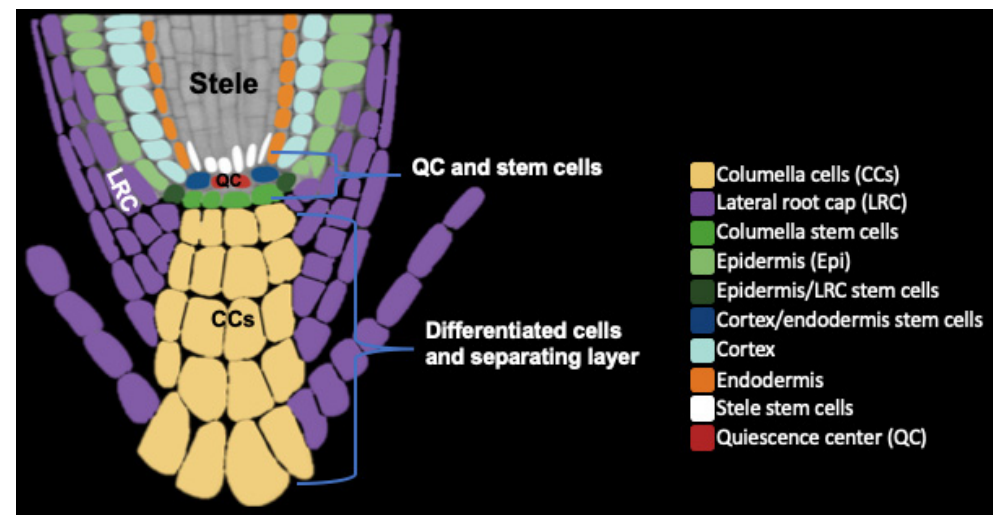
Figure 1. Schematic diagram showing different tissue organization of the root cap (CCs and LRC) and root apical meristem (QC and stem cells) regions. The last root cap layer is separating as a single intact layer known as BLCs (here colored purple and maize). Different cell types and tissues are colored differently.